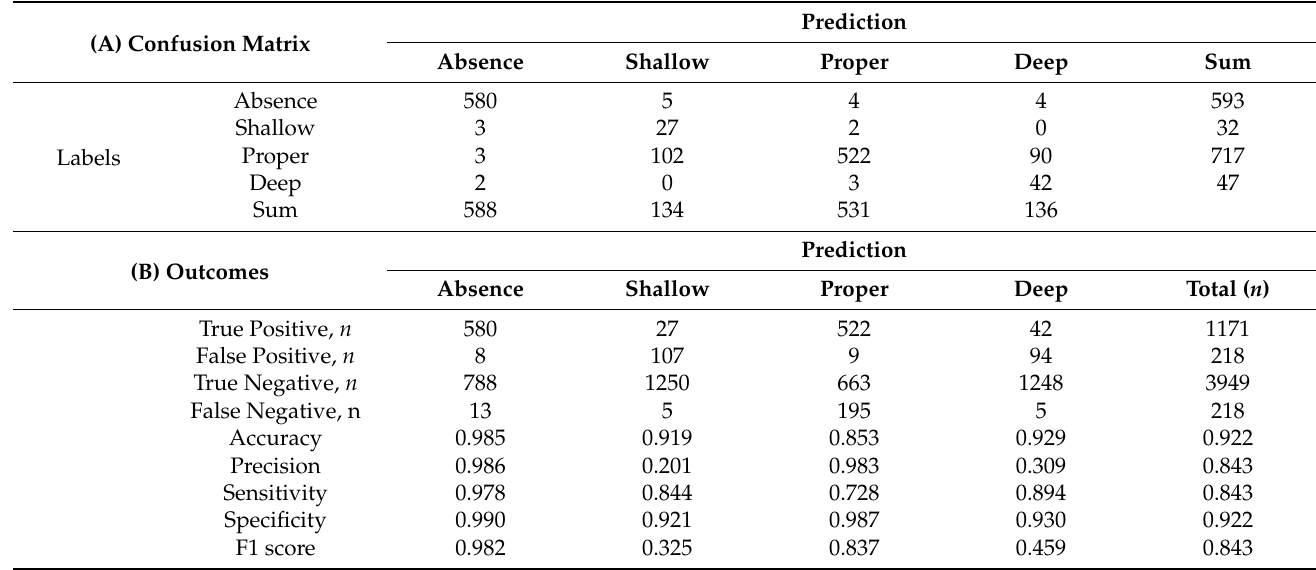
Table 3. Confusion matrix (A) and outcomes (B) of performance test for classification of four labels with non-segmented images after training with all segmented